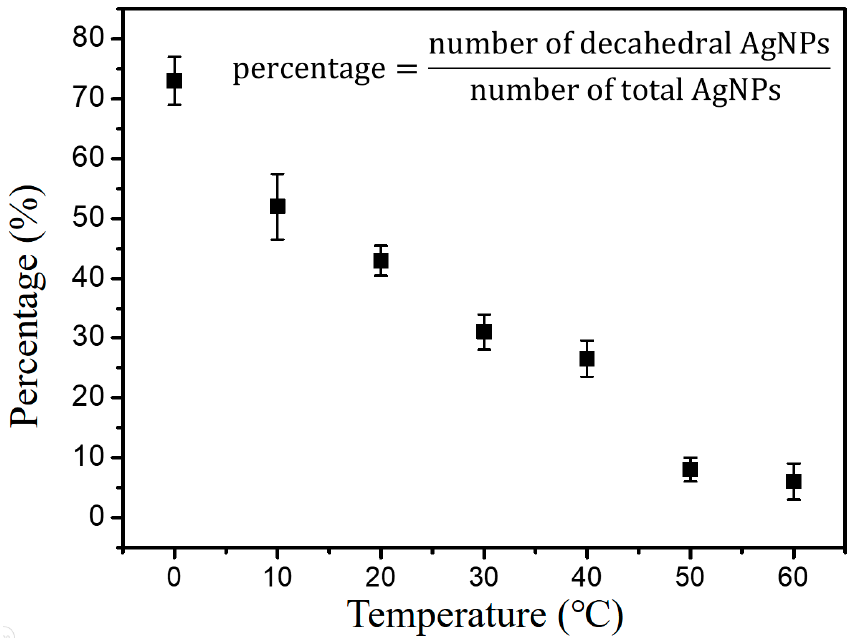
Figure 4. The percentages of D-AgNPs in the final products synthesized at various temperatures.